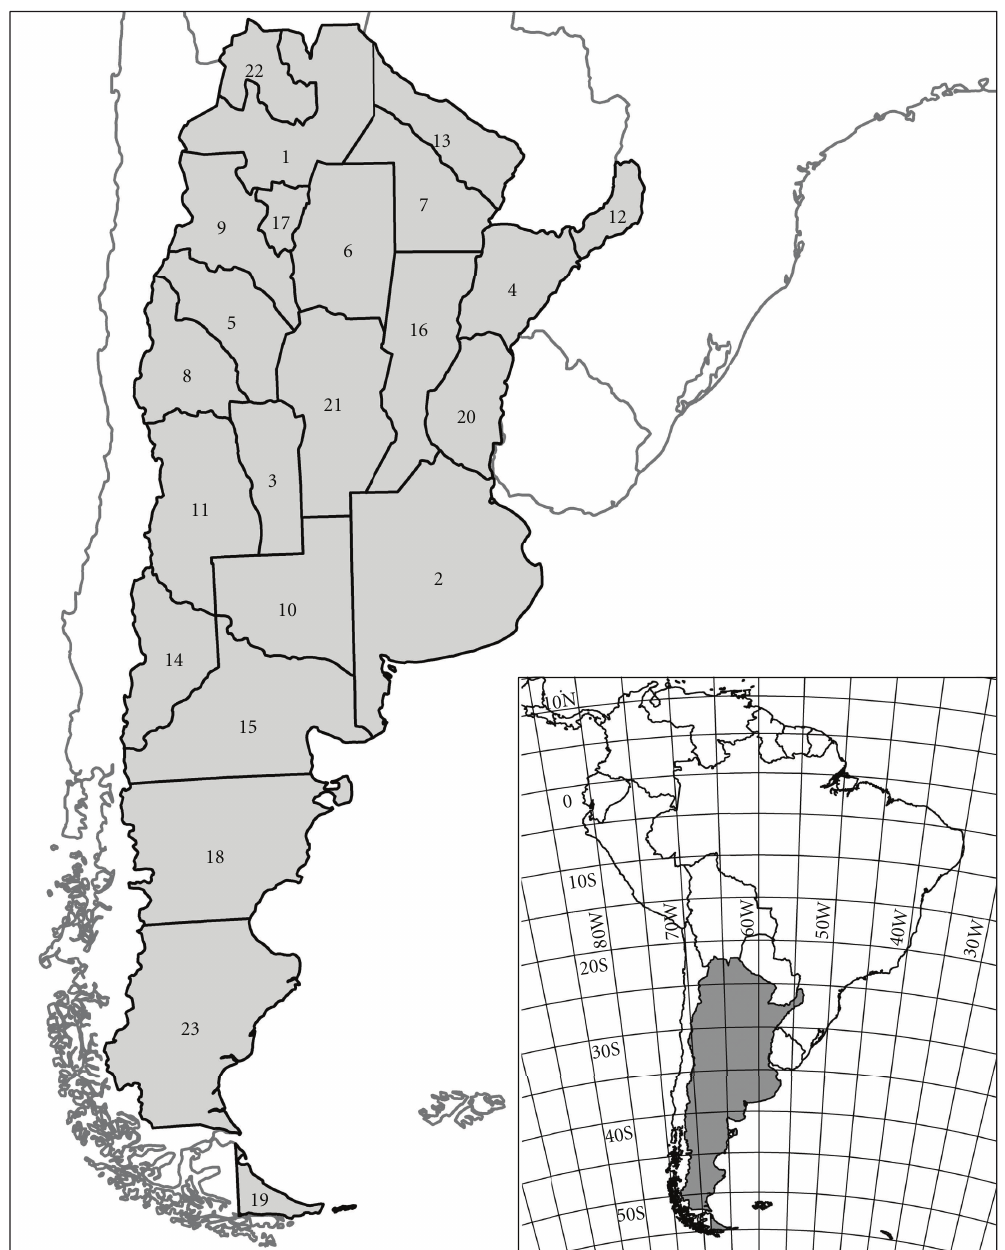
Figure 1: Political-administrative provinces of Argentina. 1: Salta, 2: Buenos Aires, 3: San Luis, 4: Corrientes, 5: La Rioja, 6: Santiago del Estero, 7: Chaco, 8: San Juan, 9: Catamarca, 10: La Pampa, 11: Mendoza, 12: Misiones, 13: Formosa, 14: Neuqu´en, 15: R´ıo Negro, 16: Santa Fe, 17: Tucum´an, 18: Chubut, 19: Tierra del Fuego, 20: Entre R´ıos, 21: C´ordoba, 22: Jujuy, 23: Santa